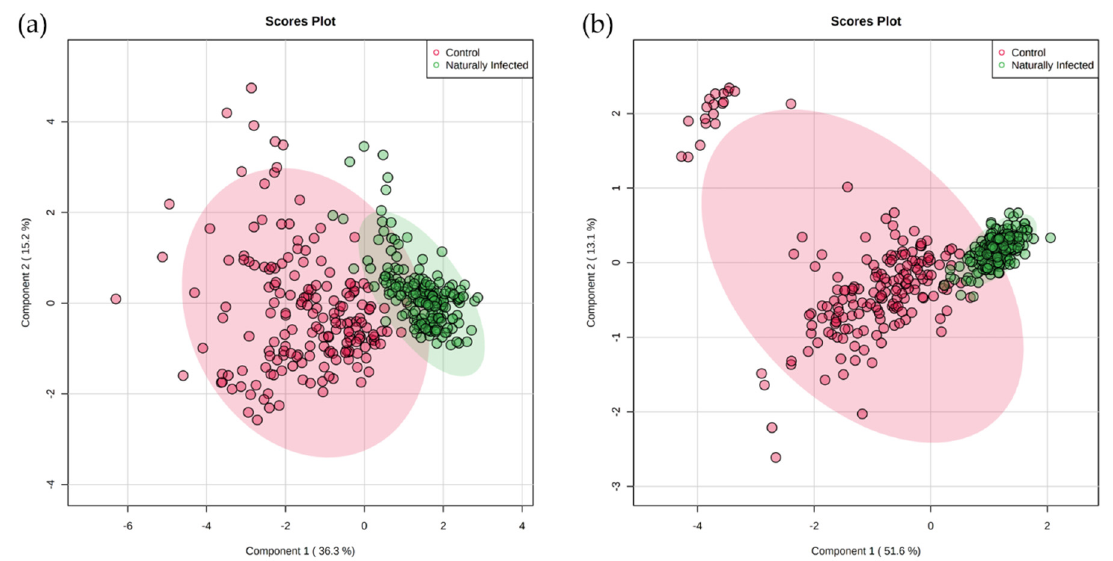
Figure 1. Partial least-squares discriminant analysis (PLS-DA) for naturally MAP-infected and control heifers in the ( a ) negative ionization and ( b ) positive ionization modes. The light red and green ellipses represent 95% confidence intervals.